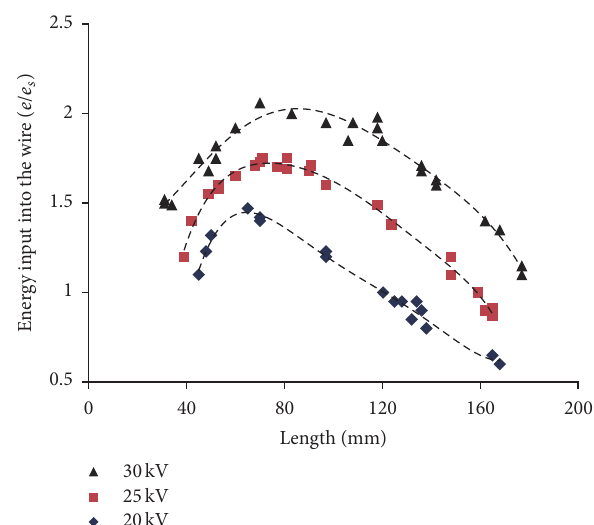
Figure 2: Energy input into the wire during explosion versus the exploded wire length and the